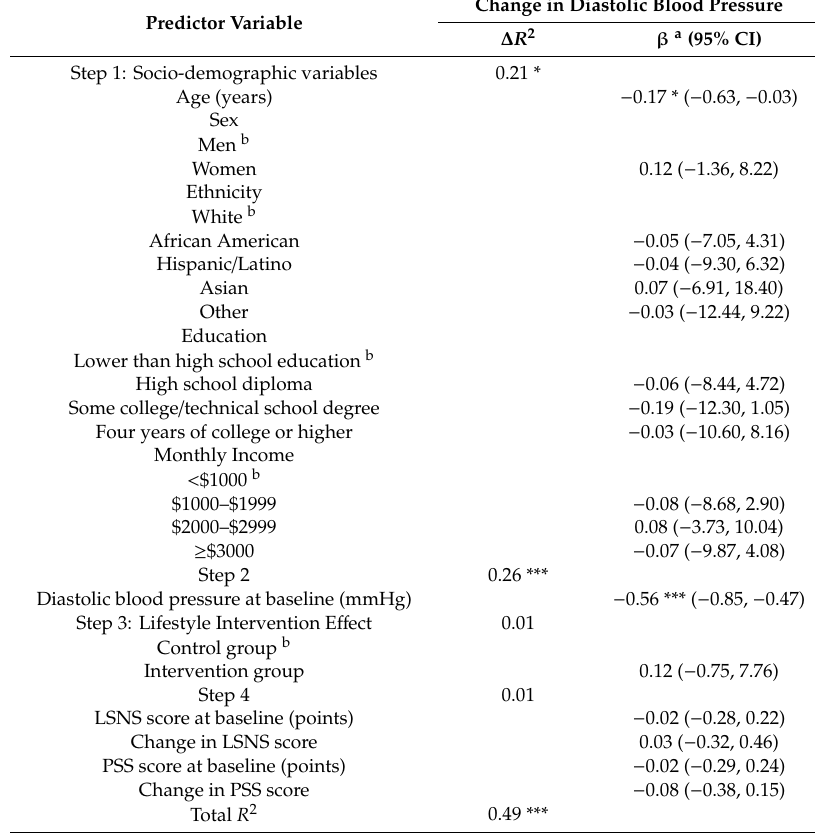
Table 3. Hierarchical multiple regression analyses examining the association of the lifestyle intervention e ff ect with change in diastolic blood pressure ( n =